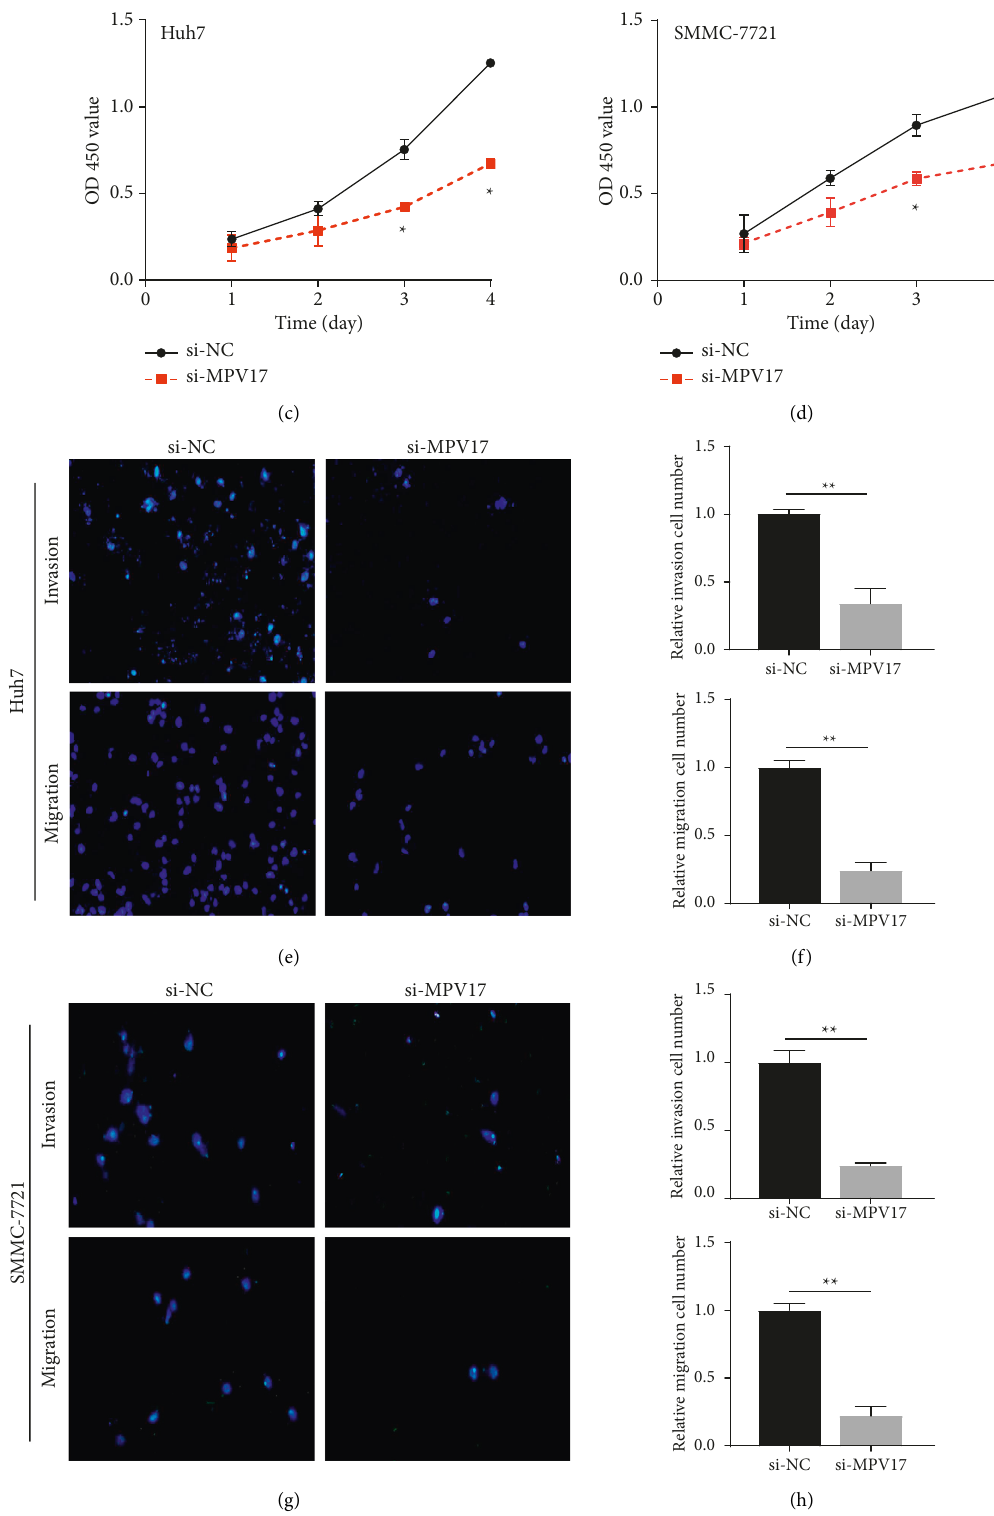
Figure 8: MPV17 knockdown weakened cell proliferation, migration, and invasion abilities. (a, b) Transfection of si-MPV17 in SMMC-7721 and Huh7 cells. (c, d), Knockdown of MPV17 led to the suppression of cell proliferation ability. (e, h), MPV17 knockdown resulted in reduced cell migration and invasion abilities. ∗ P < 0 . 05; ∗∗ P < 0 .